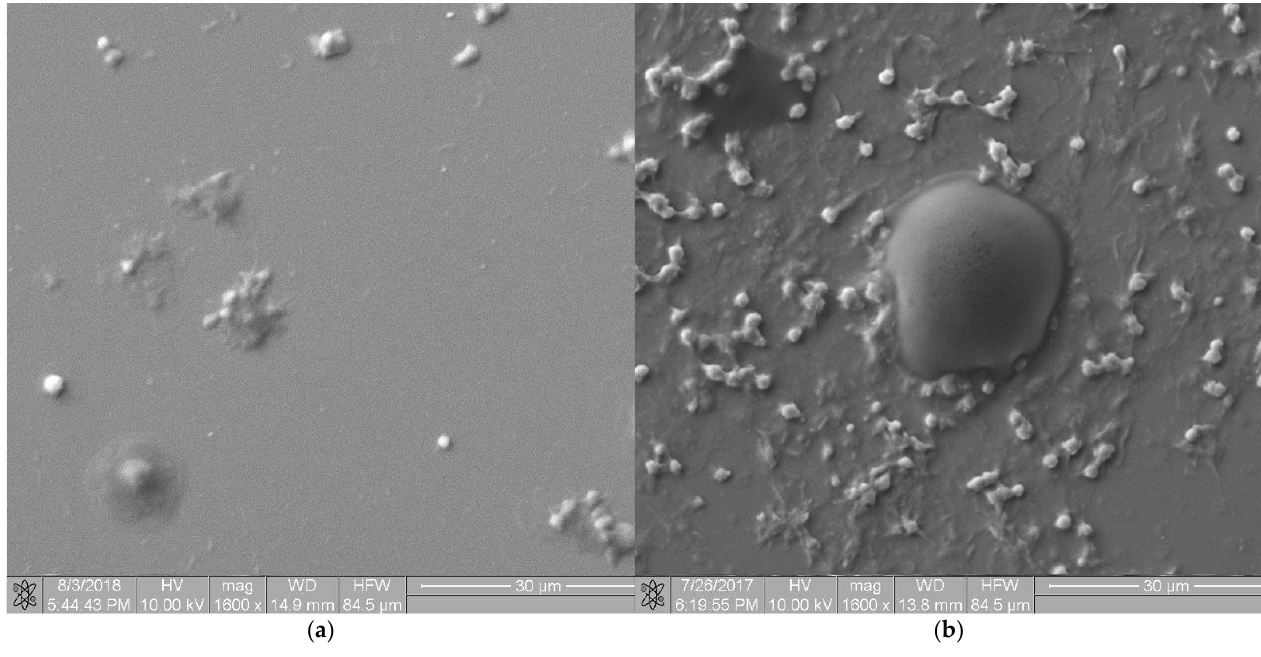
Figure 9. Blood–material interaction analysis using scanning electron microscopy (a) the occulted blood morphotypes on a-C:H surface; (b) the occulted blood morphotypes on a-C:H:N surface. Activation of a blood was measured as the percentage of platelets remaining in the blood after the shear test compared with the percentage of platelets expressing P-selectin (Figure 10a) and PAC-1 (Figure 10b). For the activation analysis of P-selectin, most coatings had little effect on activation processes, without consuming platelets that remained in the blood. The other IIb/IIIa receptor analyzed showed similar activation properties.